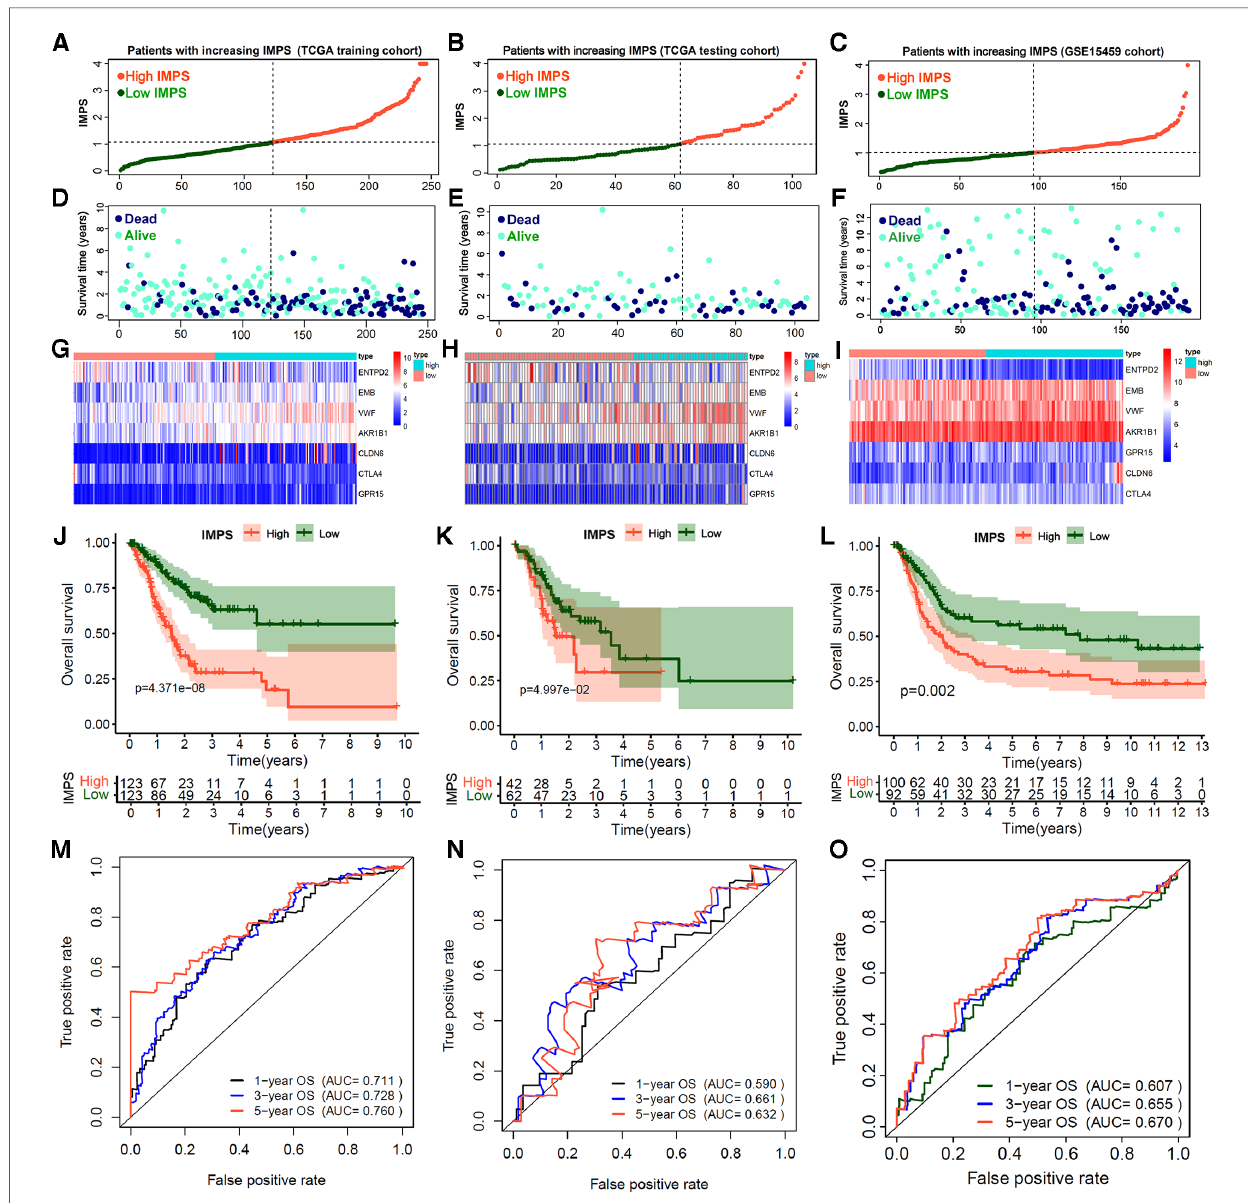
FIGURE 5 Construction and validation of immune microenvironment-related prognosis signature (IMPS) for gastric cancer gastric. ( A – F ) Distribution scatter plots of patient survival status increasing with IMPS in TCGA training ( A,D ), TCGA testing ( B,E ) and GSE15459 ( C,F ) independent validation cohorts. ( G – I ). The expression heatmap of 7 hub genes in TCGA training ( G ), TCGA testing ( H ) and GSE15459 ( I ) cohorts. ( J – L ) Kaplan-Meier analysis of patients between high- and low-IMPS in TCGA training ( J ), TCGA testing ( K ) and GSE15459 ( L ) cohorts. ( M – O ). Time-ROC curves of 1-, 3- and 5-year overall survival